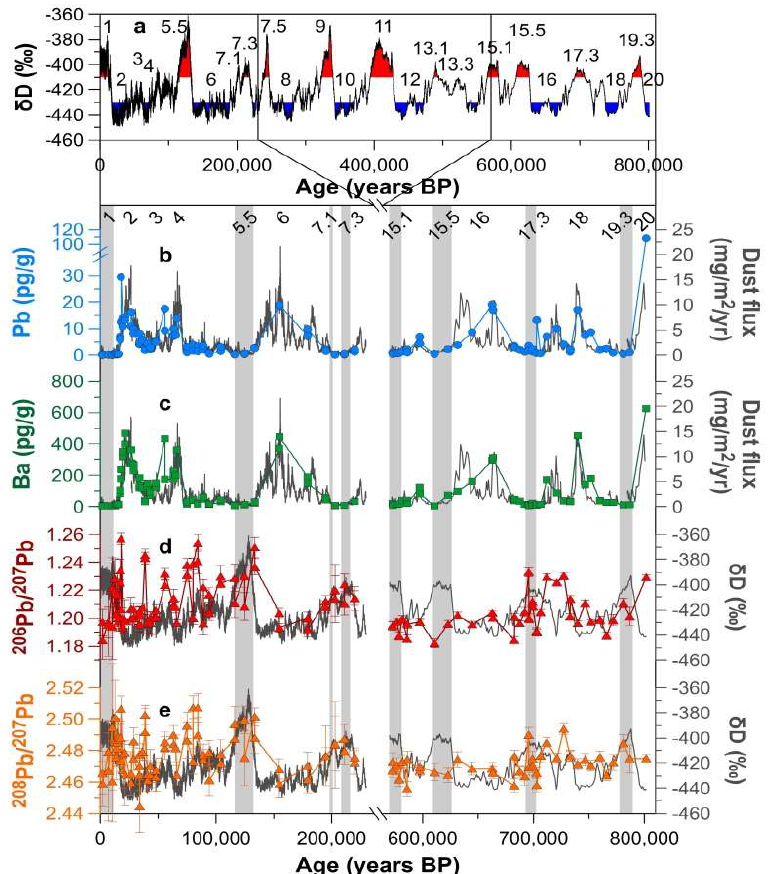
Figure 1. Changes in Pb and Ba concentrations, and Pb isotopic compositions from the EDC ice core. Also included are previously published data from the EDC ice core during the reporting period from 2 kyr (MIS 1) to 220 kyr B.P. (MIS 7.3) [17]. ( a ) The full EDC δD (Antarctic temperature proxy) profile [2] with Marine Isotope Stage (MIS) numbers [28]. ( b , c ) Changes in Pb and Ba concentrations and their deposition fluxes. Flux of dust in the EDC ice core [5] is shown as a gray solid line for comparison. ( d , e ) Changes in 206 Pb/ 207 Pb and 208 Pb/ 207 Pb ratios. The δD record in the EDC ice core is shown as a gray solid line for comparison. The vertical grey bars represent the interglacial periods when the δD values are above −405‰. All uncertainties for 206 Pb/ 207 Pb and 208 Pb/ 207 Pb ratios are 95% confidence intervals.